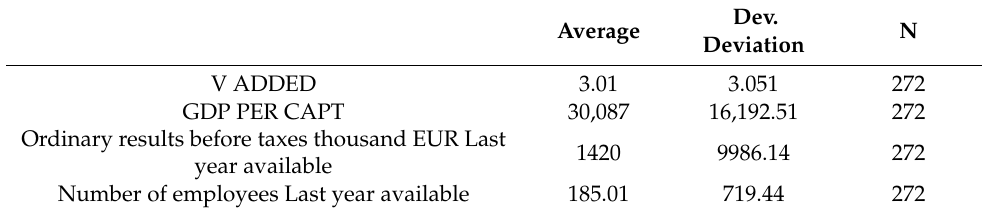
Table 10. Descriptive statistics (b). Source: own development.